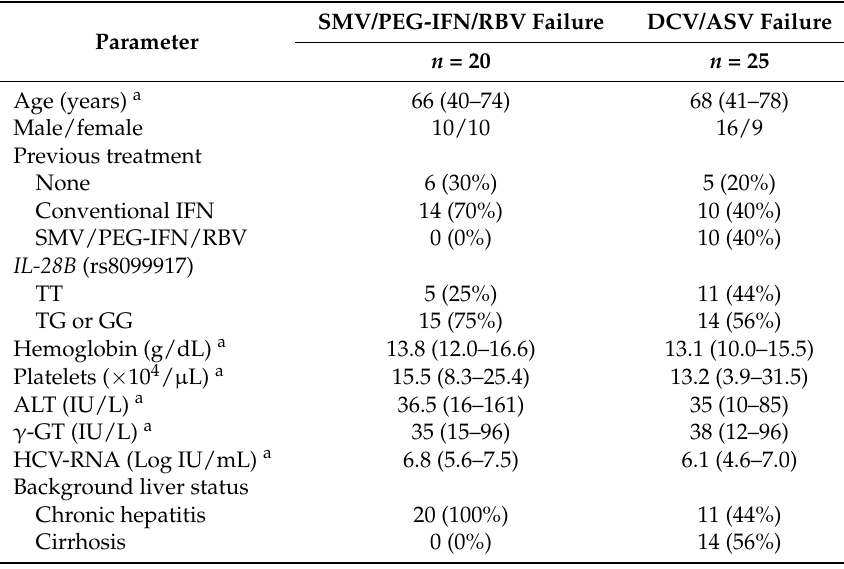
Table 4. Background characteristics of the non-SVR